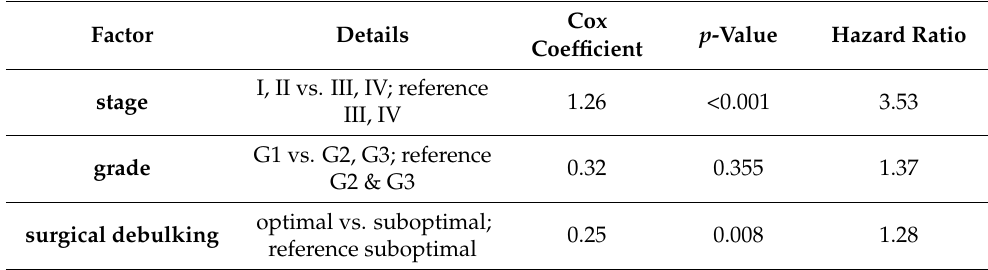
Table 2. Multivariate analysis—DFS (We calculated HR from the exponentiated coefficients (exp(Cox coefficient) = hazard ratio), based on data from CSIOVDB).